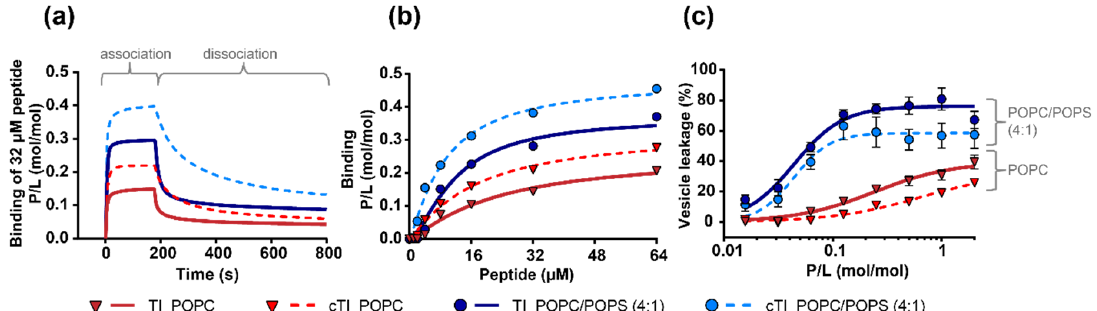
Figure 4. Membrane binding and disruption induced by tachyplesin I (TI) and cyclic tachyplesin I (cTI). Model membranes composed of 1-palmitoyl-2-oleoyl-sn-glycero-3-phosphocholine (POPC) and POPC / 1-palmitoyl-2-oleoyl-sn-glycero-3-phosphoserine (POPS) (4:1) were compared. ( a ) Surface plasmon resonance sensorgrams obtained with 32 µ M peptide injected over lipid bilayers deposited on an L1 chip surface for 180 s (association); dissociation was monitored for 600 s. Response units (RU) were converted into a peptide-to-lipid ratio (P / L (mol / mol)) to take into consideration the di ff erences in lipid packing resulting in di ff erent amounts being deposited to cover the chip surface. ( b ) The dose-response curves show P / L obtained at the end of the association phase ( t = 170 s) and plotted as a function of peptide concentration injected. ( c ) Percentage of vesicle leakage determined by fluorescence emission intensity of 5-carboxyfluorescein ( λ ex = 490 nm, λ em = 513 nm) leaking from LUVs at increasing concentrations of peptide. Lipid concentration used was 5 µ M, and the peptide was tested up to 10 µ M. Dose-response curves were fitted with one-site specific binding with Hill slope equation in GraphPad Prism. Table 6. The kinetic and a ffi nity parameters from surface plasmon resonance analysis of the interaction of 32 µ M tachyplesin I (TI) and cyclic tachyplesin I (cTI) with neutral (POPC) and negatively-charged model membranes (POPC / POPS (4:1)) and leakage induced by the same peptides and lipid systems. Lipid P / L max K D k o ff P / L o ff LC max Peptide System (mol / mol) 1 ( µ M) 1 (x 10 − 2 s − 1 ) 2 (mol / mol) 2 (%) 3 TI 0.26 ± 0.06 22.4 ± 10.9 1.50 ± 0.11 0.046 ± 0.001 39.5 ± 4.6 POPC cTI 0.33 ± 0.07 16.7 ± 8.4 TI POPC / POPS 0.37 ± 0.04 (4:1) 58.5 ± 3.6